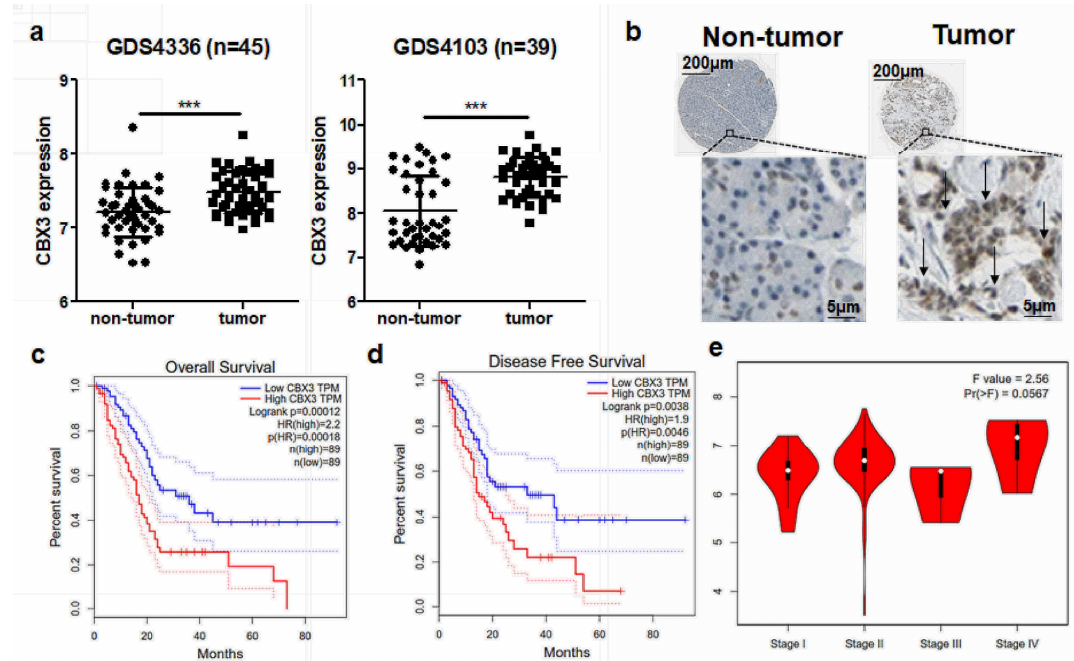
Figure 1. CBX3 was overexpressed in PAAD and predicted poor prognosis. ( a ) Data of CBX3 expression in human PAAD and non-tumor tissues were extracted from GEO dataset GDS4336 and GDS4103. It was shown that CBX3 was highly expressed in PAAD tissue. *** p < 0.001 when comparison was made between groups; ( b ) Protein expression of CBX3 was accessed from Human Protein Atlas project. Expression of HP1γ in human PAAD slides was significantly increased, as evidence of positive staining of the protein (brown dots). The black arrows showed cells with strong expression of HP1γ; ( c ) Data of expression of CBX3 and survival time of corresponding patients were extracted from TCGA database. KM plots showed that patients with CBX3 expression higher than median level had shorter overall survival. The area between the upper and lower blue/red dash lines indicated areas within 95% confident intervals (CIs); ( d ) Data of expression of CBX3 and survival time of corresponding patients were extracted from TCGA database. KM plots showed that patients with CBX3 expression higher than median level had shorter disease-free survival. The area between the upper and lower blue/red dash lines indicated areas within 95% CIs; ( e ) Data were collected from Gepia database. The results showed that CBX3 was increase during the disease progression of PAAD.